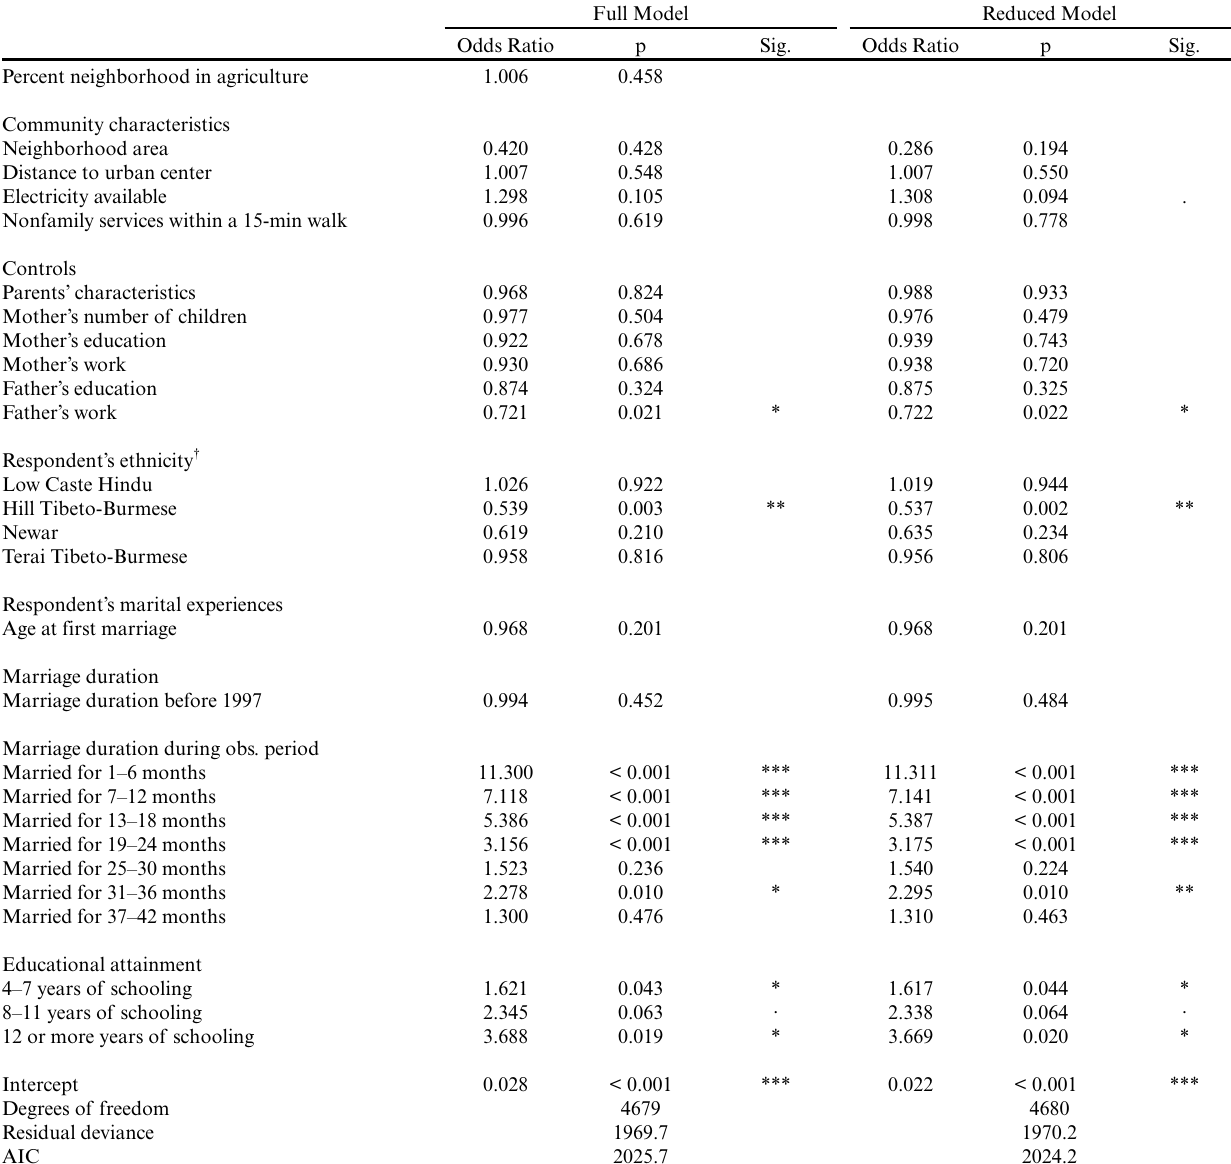
Table 4 . Models of first birth timing (following the work of Ghimire and Hoelter 2007, Ghimire and Axinn 2010). Odds-ratios are from a discrete-time event history analysis predicting monthly hazard of first birth. Listed in parentheses are the z-scores for each odds- ratio.